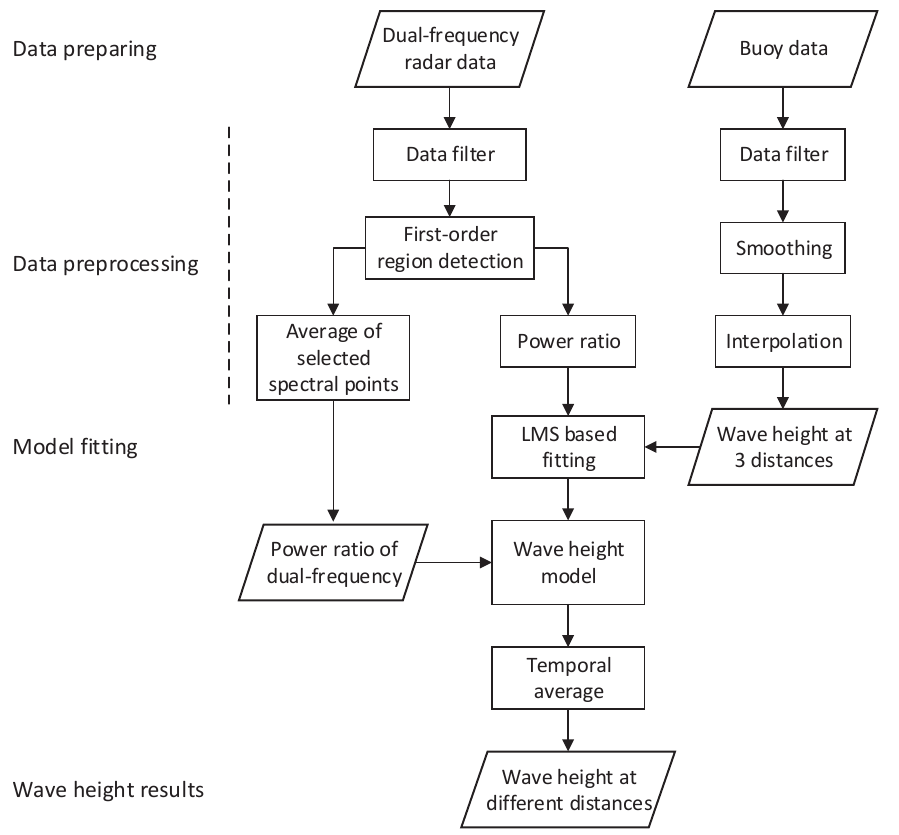
Figure 3. Block diagram of the wave height estimation